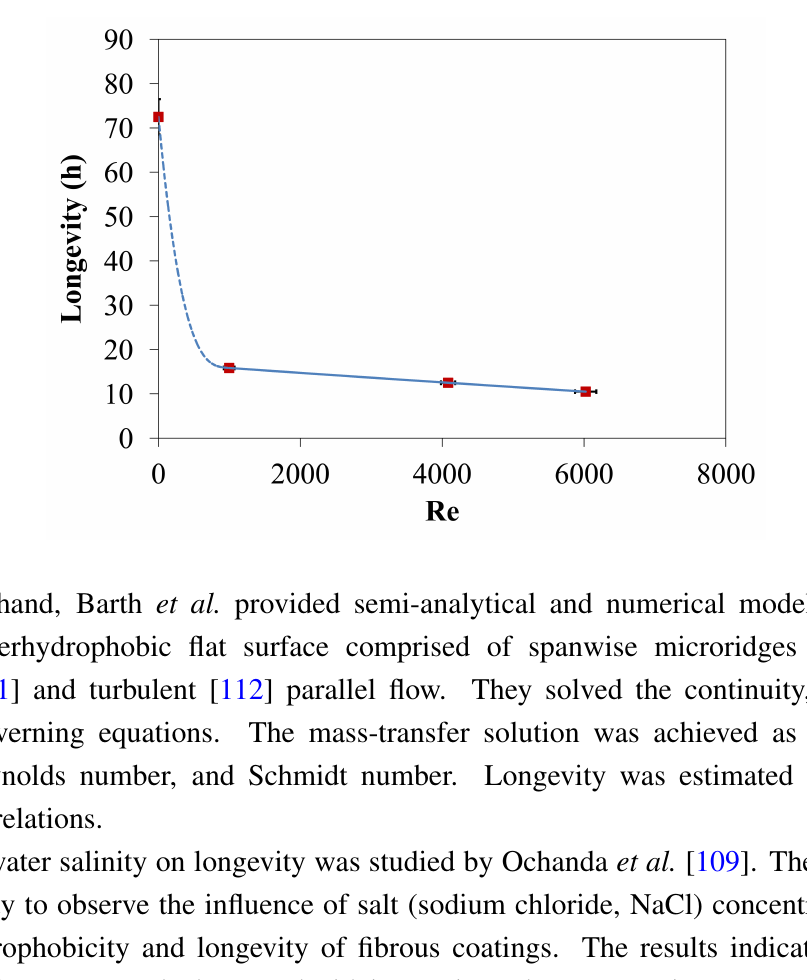
Figure 39. Effect of water movement on longevity of superhydrophobic fibrous coating. Solid and broken lines are best fit of experimental data in forced, free and mixed convection regimes. From Samaha et al.